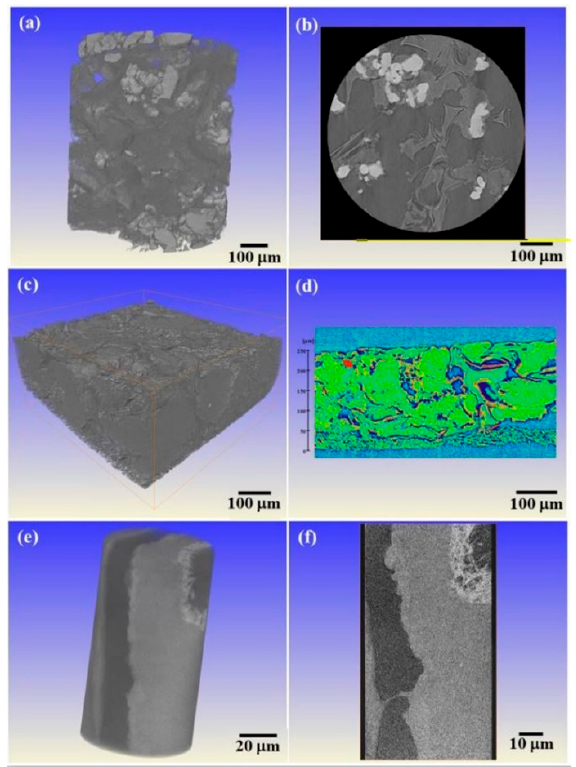
Figure 9. 3D XRT volume renderings and 2D slices of the 3D grapheme foam electrodes with 10.1 mg cm –2 sulfur loading: ( a , b ) original state; ( c – f ) after 1000 charge/discharge cycles; ( a – d ) the pixel size is about 0.7 µm; and ( e , f ) the pixel size is about 64 nm.